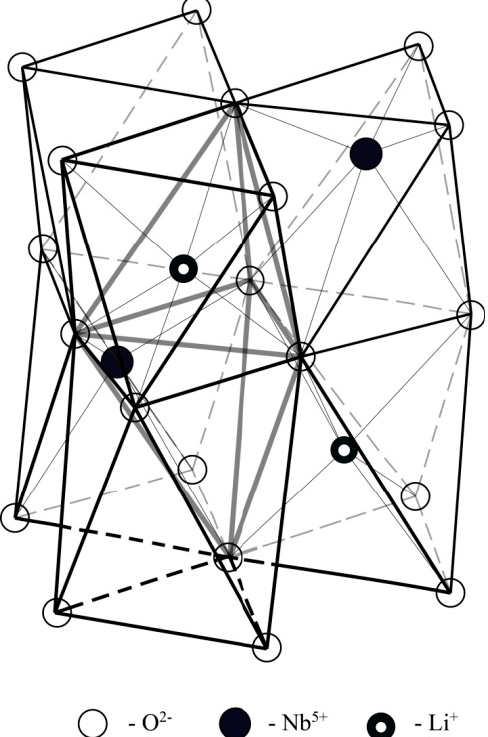
Figure 13. Two niobium (Nb 1 , Nb 2 ), two lithium (Li 1 , Li 2 ), and two vacant (V 1 , V 2 ) oxygen octahedra forming two tetrahedral voids highlighted in grey. The figure is reproduced with the permission of Pleiades Publishing from the paper N.V. Sidorov et al., J. Struct. Chem. 2021 V. 62 № 2 P. 221–229, DOI: https://doi.org/10.1134/S0022476621020050 (accessed on 26 March 2021).